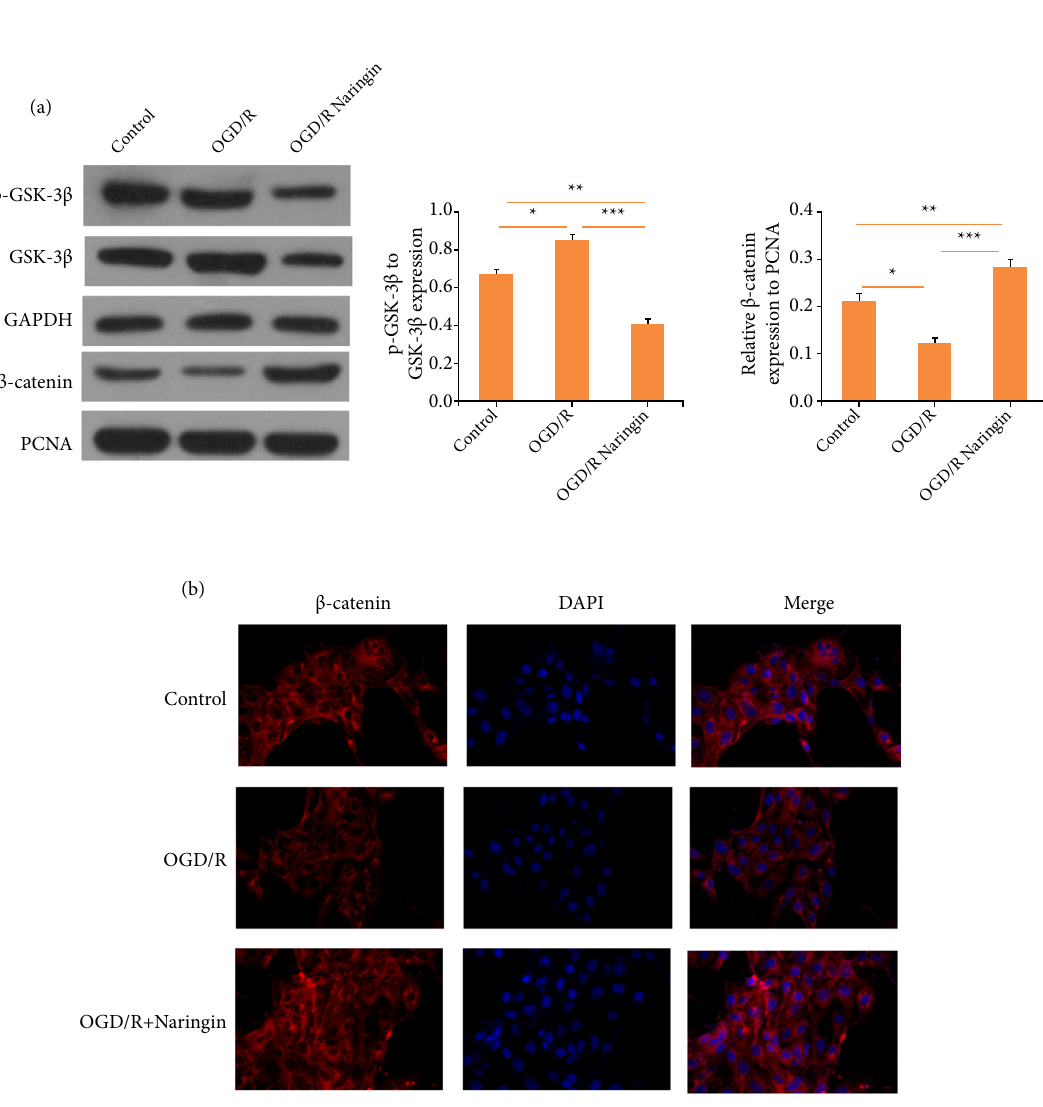
Figure 4 - Naringin attenuates oxygen-glucose deprivation/recovery (OGD/R)-induced apoptosis of cardiomyocytes via GSK-3 β / β -catenin signaling pathway. (a) Western blots for GSK-3 β / β -catenin signaling pathway. (b) Immunofluorescence staining for β